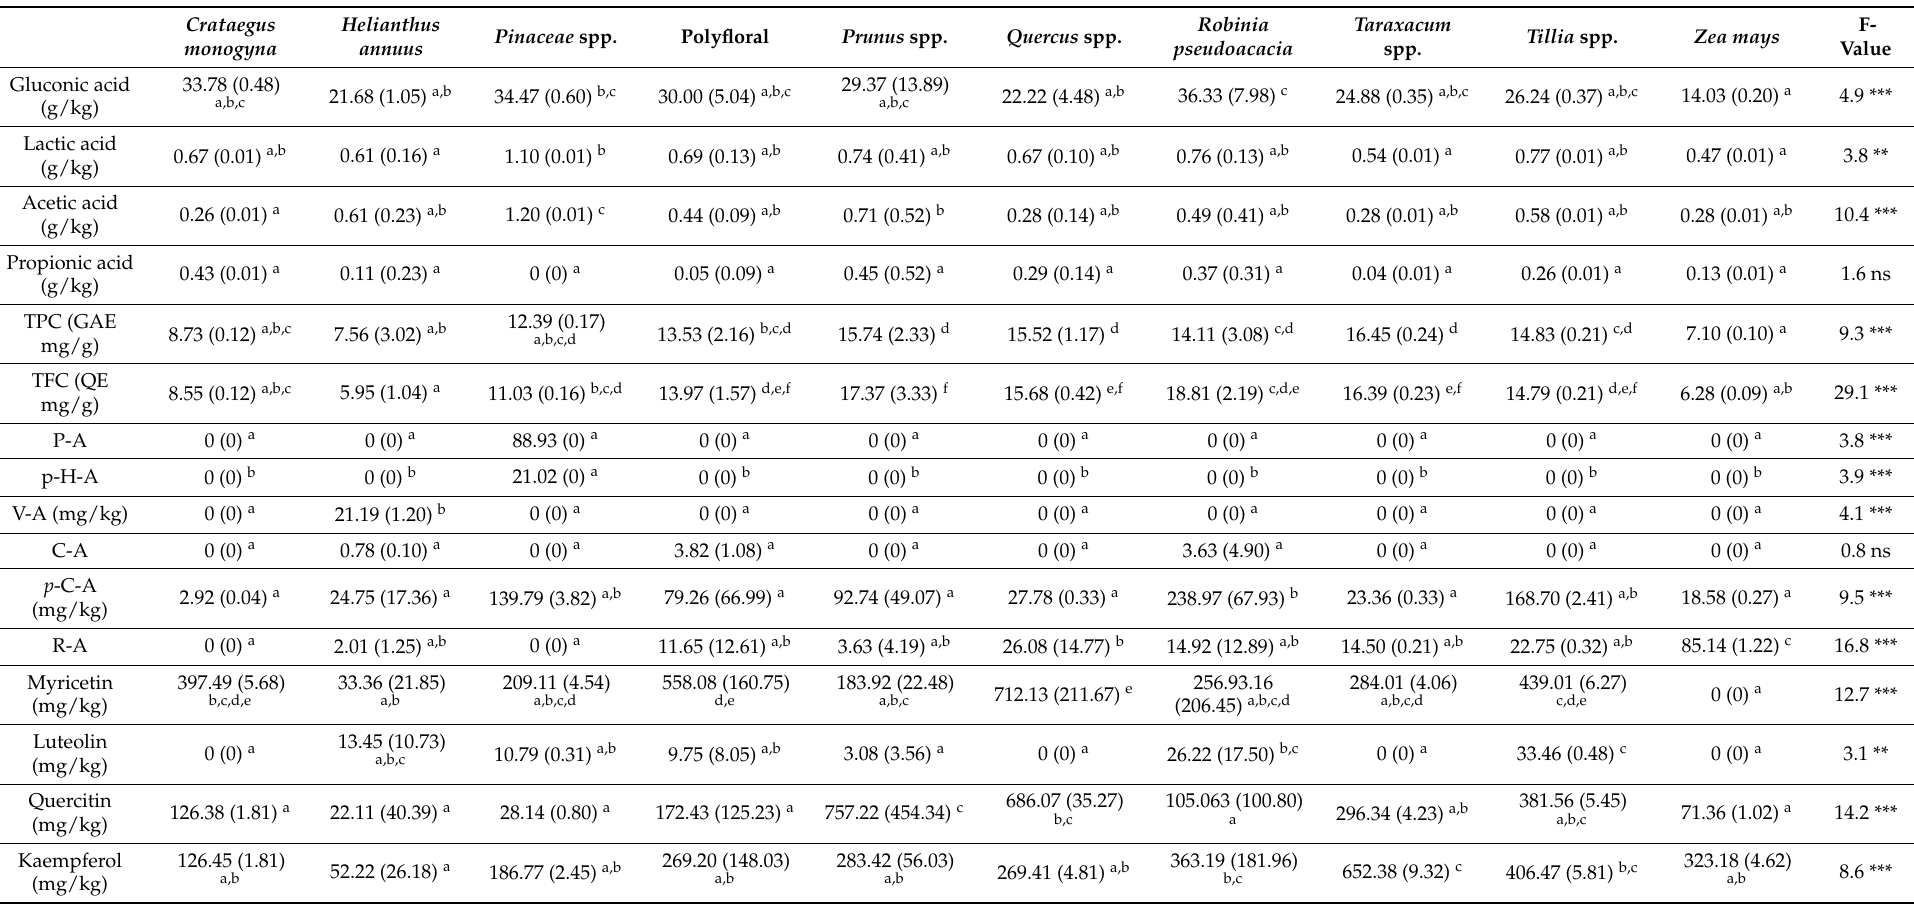
Table 3. Organic acids, total phenolic content, total flavonoid content and individual phenolics compounds of bee pollen (mean values and standard deviation in